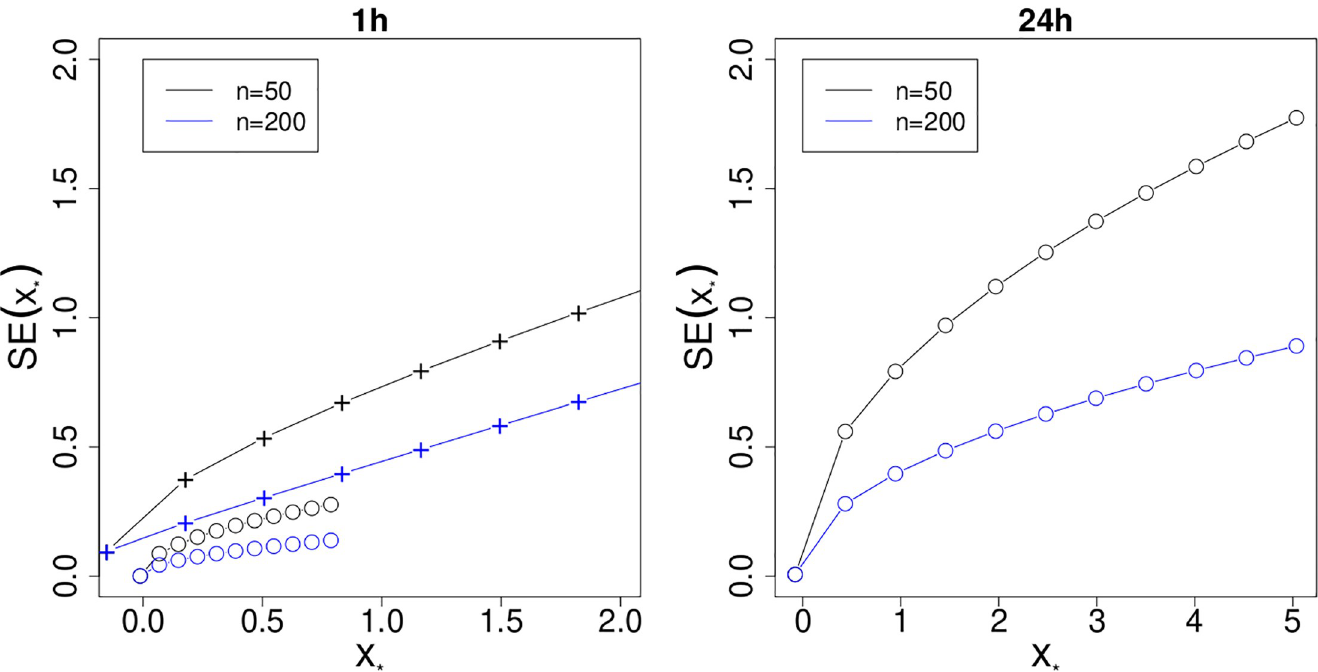
Fig 6. Plots of standard errors, SE( x � ), versus dose estimates, x � , for 1h (left) or 24h (right) after exposure, for n � = 50 (black) or 200 (blue) available cells, respectively. Measurements symbolized through circles � assume that the given calibration curve is true, while those displayed through a + symbol assume that it is rejected and hence a reference curve is used. The yields corresponding to the circles/crosses along the curves are given by 0, 1, 2, ... , 10.